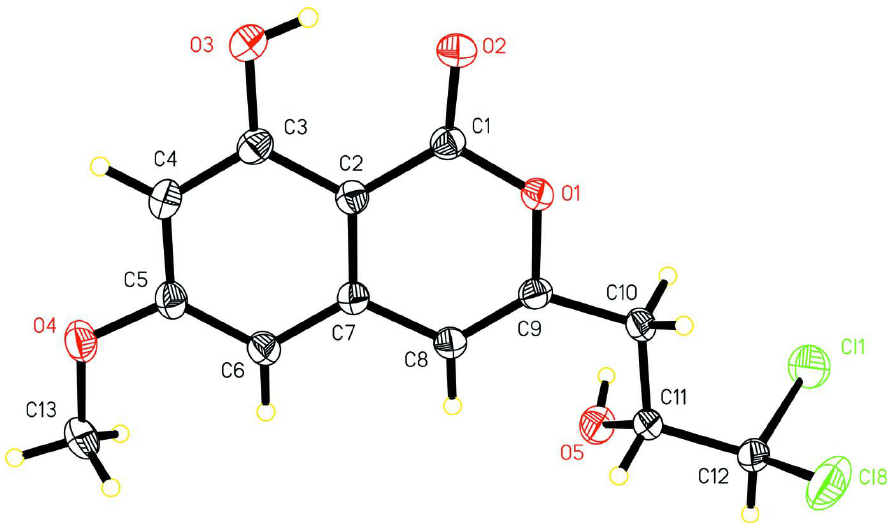
View of the molecules in the asymmetric unit of (I), with anisotropic displacement parameters drawn at the 50% probability